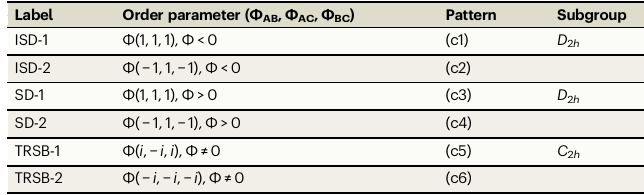
Table 1 | CDW orders in the mean- fi eld analysis